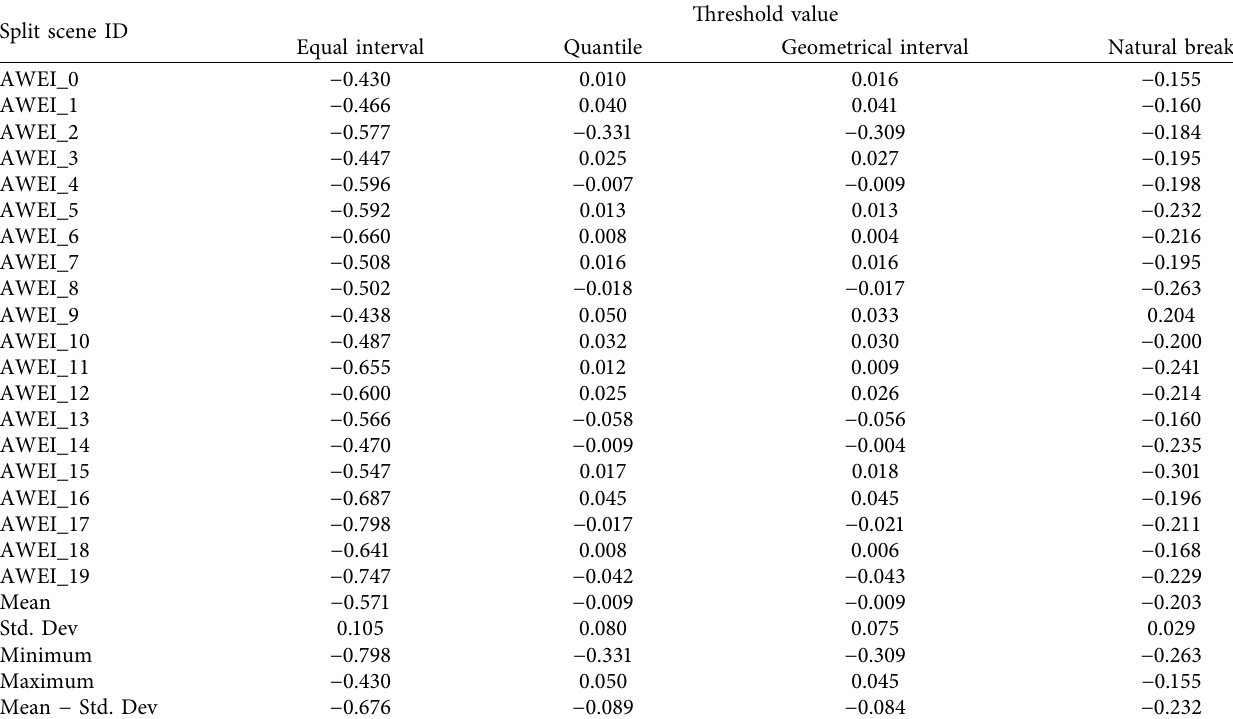
Table 1: Result calculation of the local thresholds based on the second-stage split scene image selection in the scene data ( XC ″ ) of the subscene images ( XCi ″ ) using the equal interval, quantile, geometrical interval, and natural break